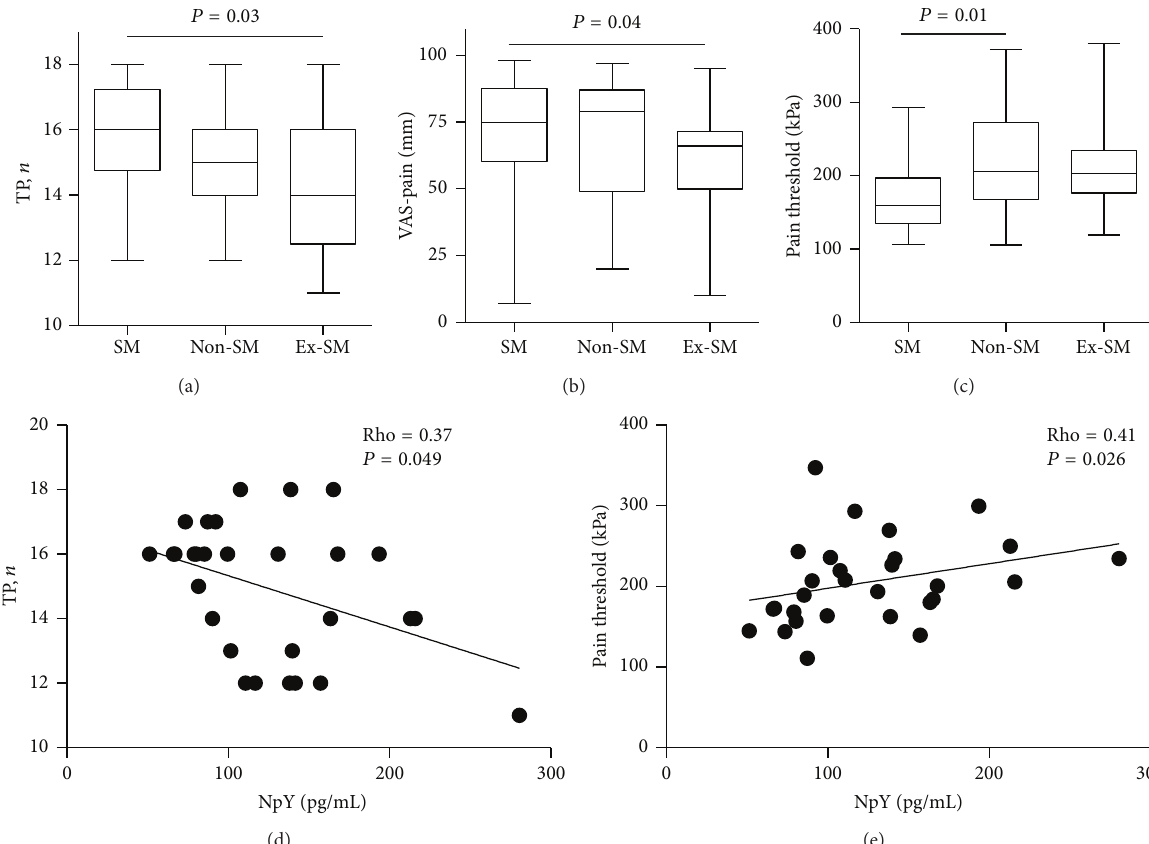
Figure 1: Clinical measurements of pain in patients with fibromyalgia. By smoking habits, the patients were assigned as smokers (SM, 𝑛 = 18 ), ex-smokers (Ex-SM, 𝑛 = 25 ), and nonsmokers (non-SM, 𝑛 = 19 ). (a) Pain distribution was evaluated in 18 standard tender points (TP). (b) Pain intensity was measured by a visual analogue scale (VAS, 0–100 mm). (c) Pressure pain threshold was measured using an algometer. Plots indicate median, interquartile range, and 𝑃 values. The comparison between the groups was done by Kruskal-Wallis with Dunn’s post hoc test. Scatterplots show correlation of serum levels of neuropeptide Y (NpY) with TP number (d) and with pressure pain threshold values (e). The Spearman’s correlation test was